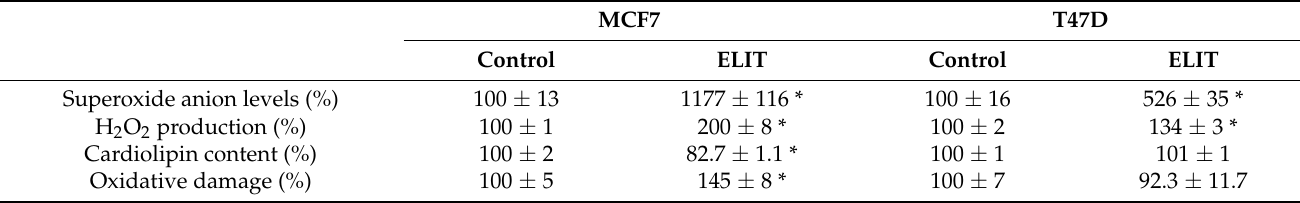
Table 2. Oxidative stress in MCF7 and T47D breast cancer cell lines.